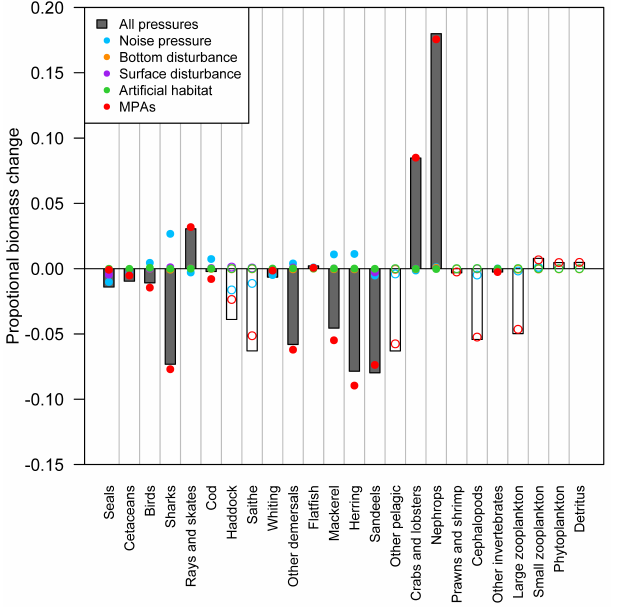
Fig. 7. Proportional change in the biomass of functional groups in the Firth of Clyde marine spatial planning (MSP)-Ecopath with Ecosim model after the implementation of gaming start- up pressure layers. The baseline (0) denotes the biomass prior to the addition of environmental pressures. Hollow bars and points denote changes that are not explicitly shown to MSP game participants. MPAs = marine protected areas.